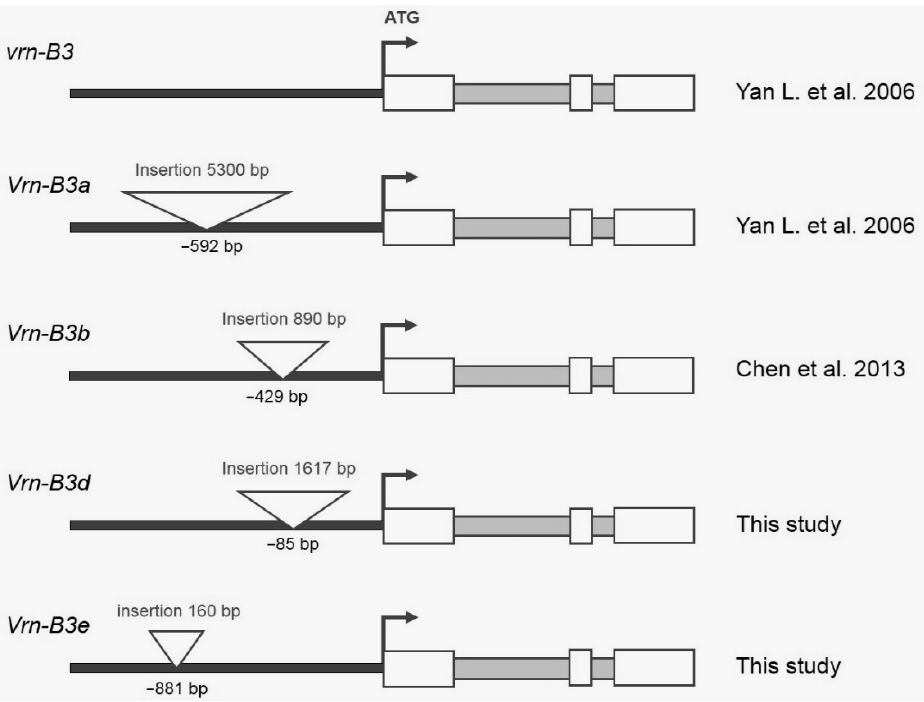
Figure 2. Allelic variations of the Vrn-B3 gene identified in wheat varieties in this study. The white triangles represent insertions, the white rectangles represent exons, and the black arrows represent the transcriptional start.